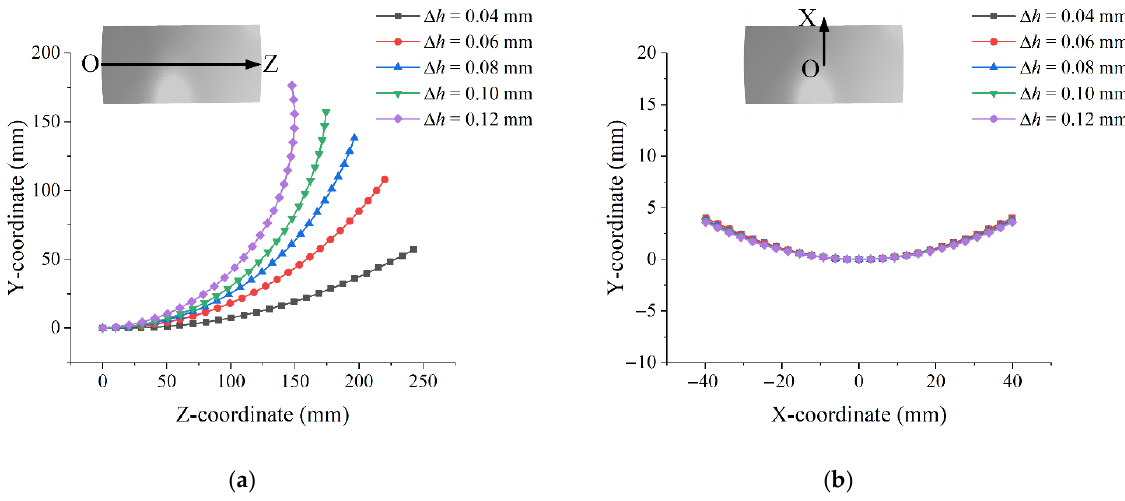
Figure 7. Bending deformation of the formed spherical surface parts in FEM: ( a ) longitudinal bend deformation; ( b ) transverse bend deformation.